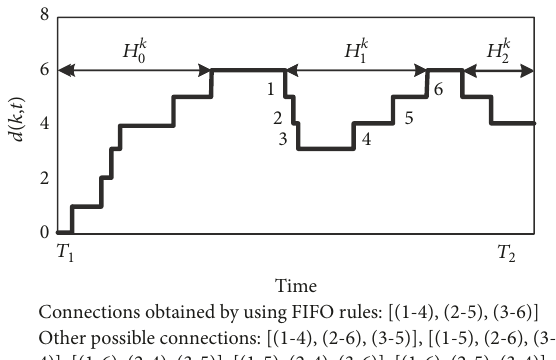
Figure 2: An example of building a connection in a flat peak time 𝐻 𝑘 1 .